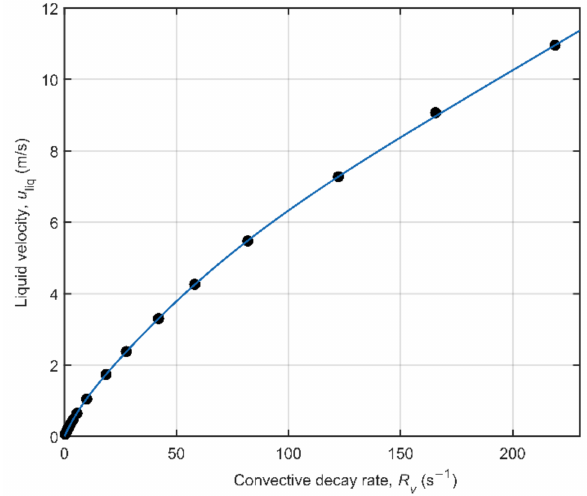
Figure 11. The reference liquid flow velocity, u liq , as a function of the convective decay rate, R v , that was obtained by fitting an exponential decay to T 2,eff -corrected LFA-CPMG signals. The solid line indicates the calibration function used in the two-phase flow experiments.